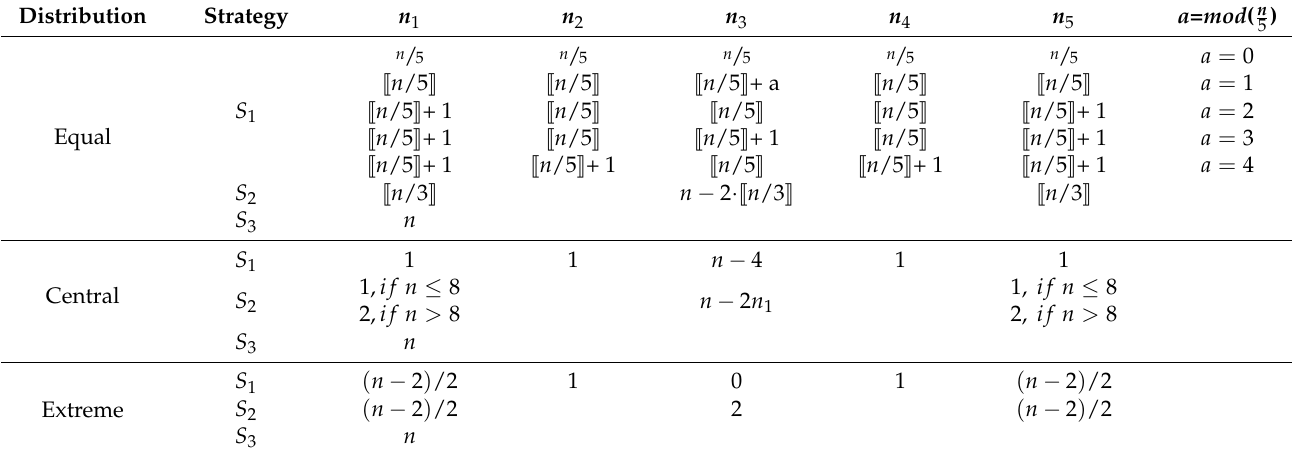
Table 2. Number of hoppers for each group according to the S 1 , S 2 , and S 3 strategies and distribution of hoppers.